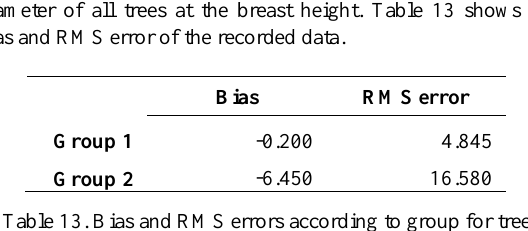
Table 13. Bias and RMS errors according to group for tree DBH measurement in task 3.